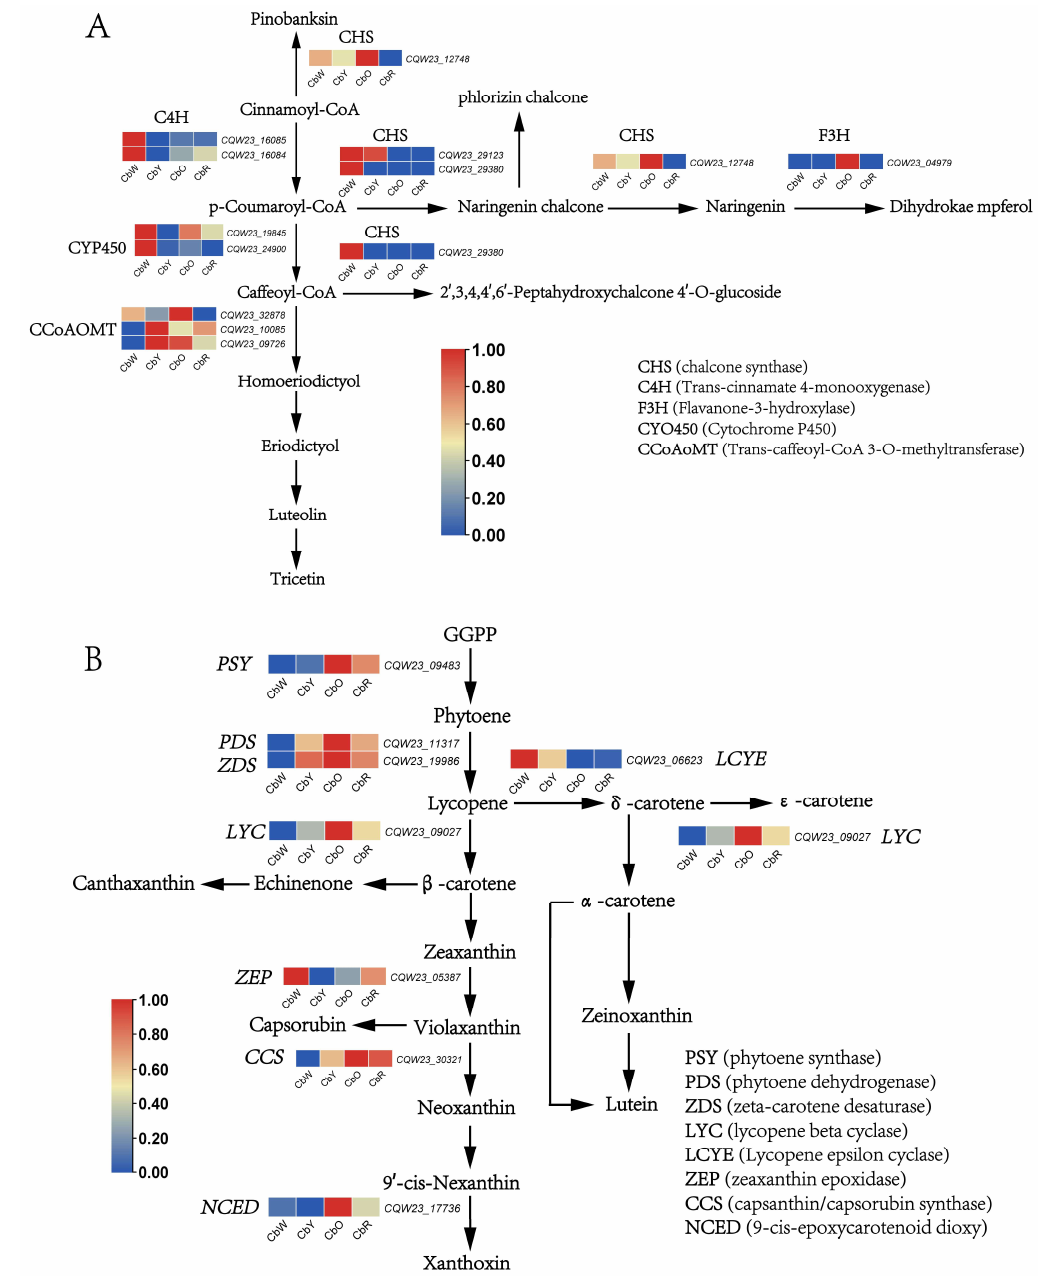
Figure 8. Flavonoid and carotenoid biosynthesis pathway diagrams. ( A ) Diagram of flavonoid biosynthesis pathway; ( B ) Diagram of carotenoid biosynthesis pathway. (This diagram was drawn based on references to relevant literature and data in this study).